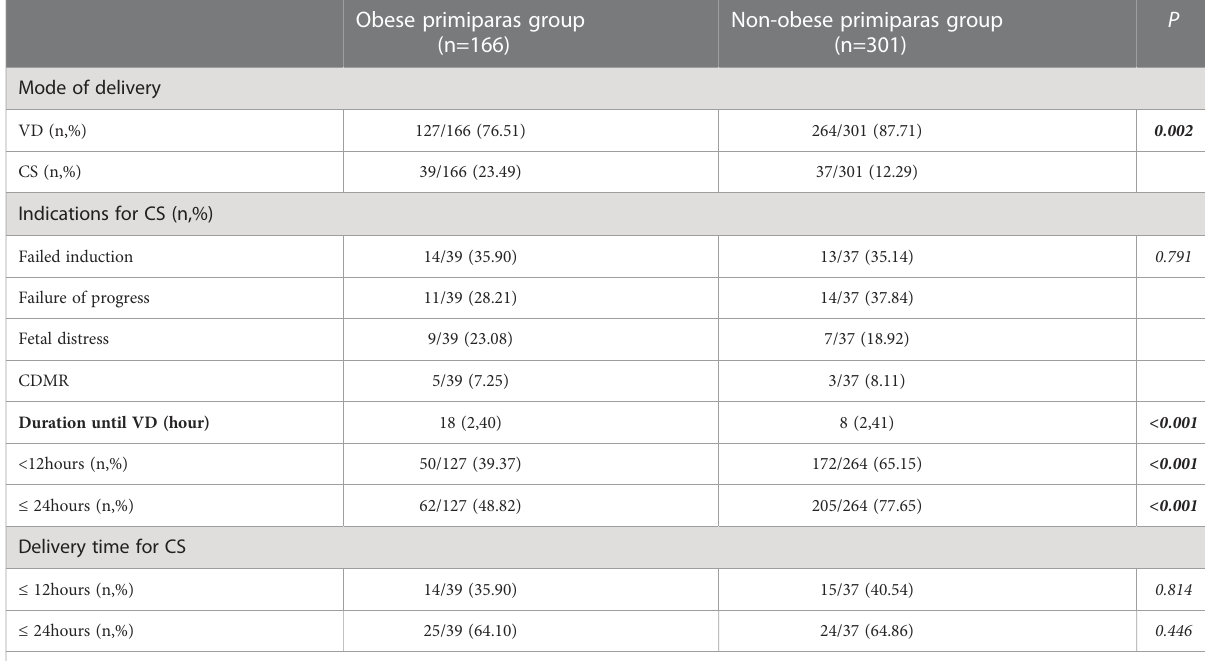
TABLE 2 The results of labor induction and delivery.